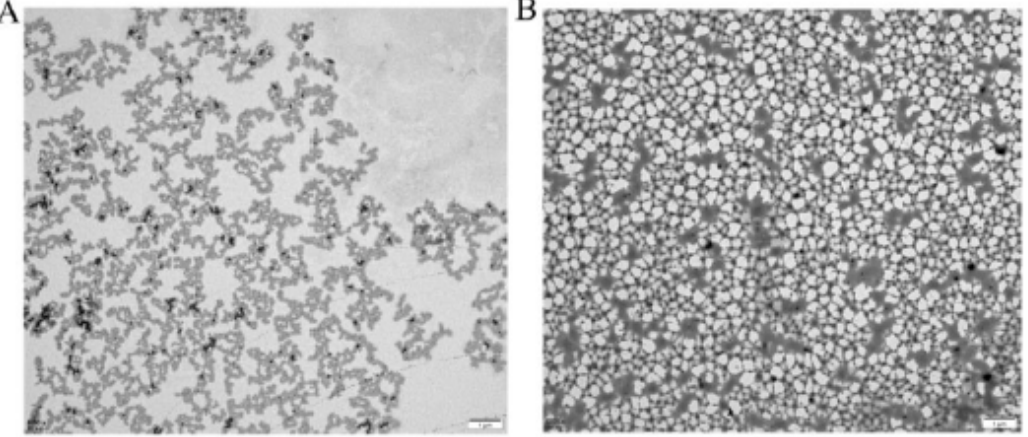
Figure 5. Transmission electron microscopy (TEM) images of ( A ) MSP1-1 and ( B ) MSP1-2 in 0.9% NaCl solution.